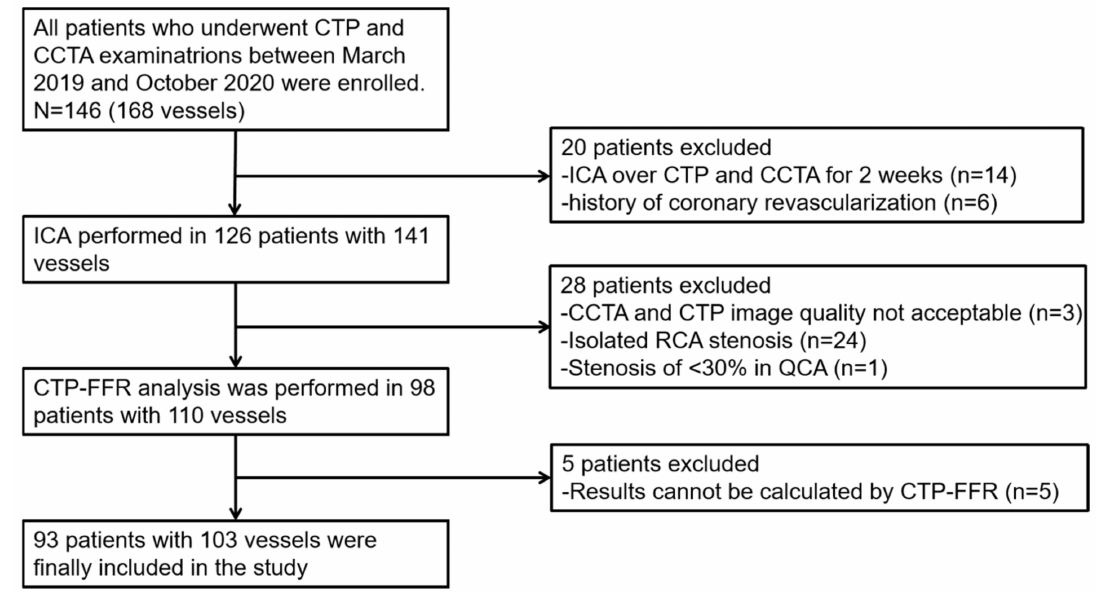
Figure 1. Study flow chart. CCTA = coronary computed tomography angiography; CTP-FFR = computed tomography perfusion (CTP)-derived fractional flow reserve (FFR); ICA = invasive coronary angiography; QCA = quantitative coronary angiography; RCA = right coronary